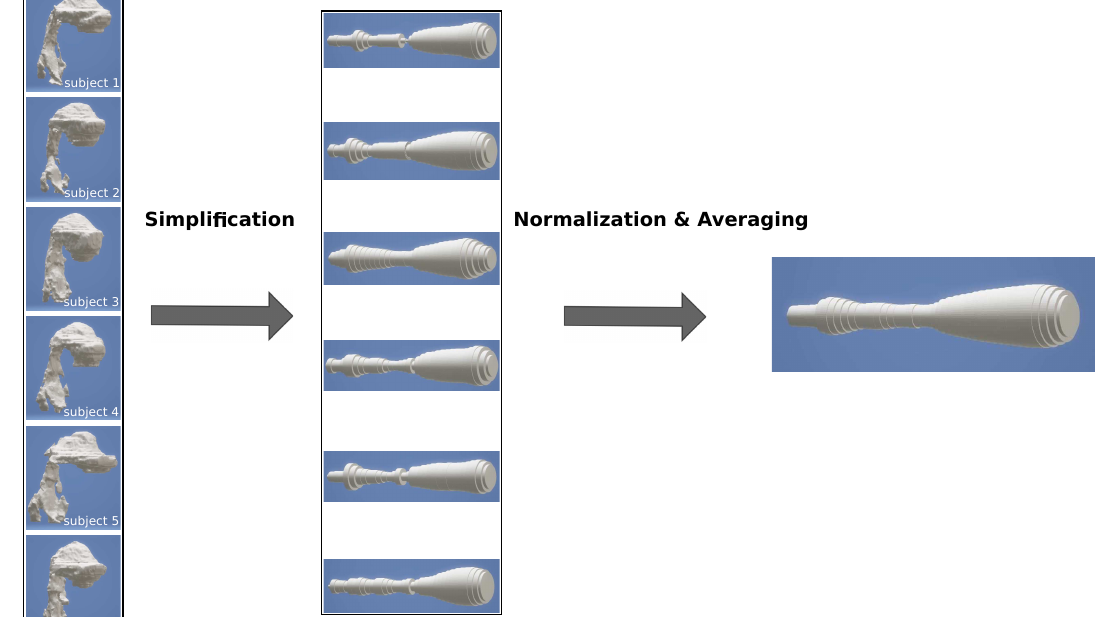
Figure 2. Simplification according to the method proposed by Story et al. [13] and averaging procedure of the VT geometries obtained from six tenors based on the MRI data by Echternach et al. [34].